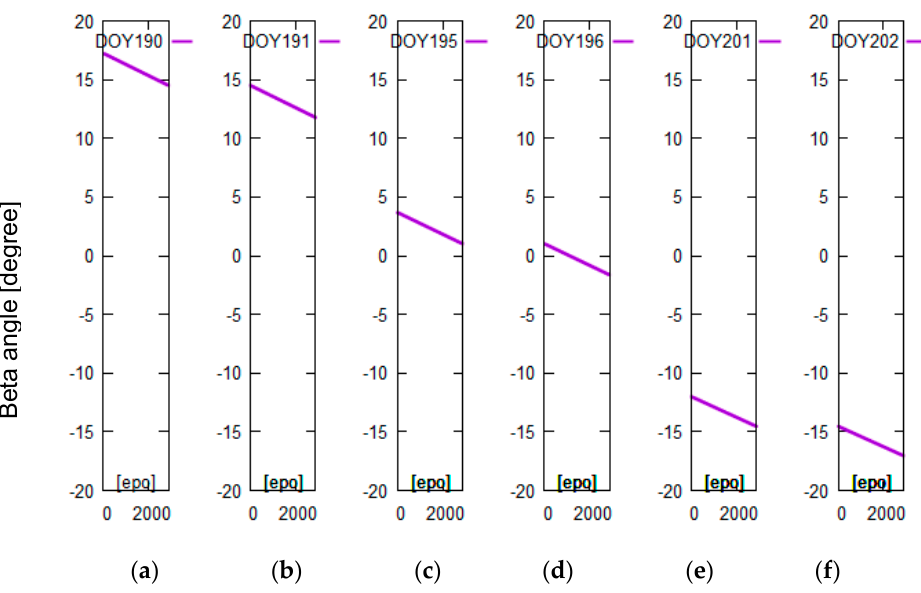
Figure 3. Variation of Jason-3 beta angles near ± 14.6° and 1.06°. the transition threshold of the combined attitude in DOY190-191 (Figure 3 a , b ), DOY195-196 (Figure 3 c , d ) and DOY201-202 (Figure 3 e , f ).